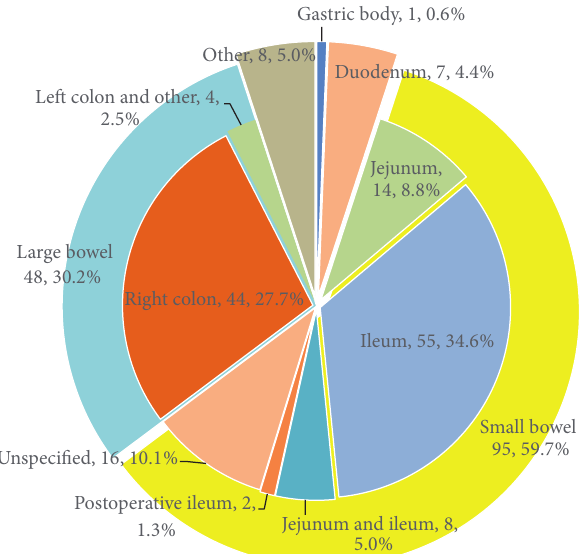
proximal to the ileal-sigmoid anastomosis (one case) and bypassed ileal segment (one case). Left colon and other included descending colon (one case), lower sigmoid (one case), rectosigmoid junction (one case), and ileocaecal valve, ascending colon, transverse colon, and descending colon were all involved in one case. Other locations included jejunum and duodenum (3 cases); jejunum, duodenum, and pylorus (one case); terminal ileum, ileocaecal valve, caecum, and ascending colon (one case); terminal ileum and ascending colon (one case); terminal ileum and ileocaecal junction (one case); terminal ileum and ileocaecal valve (one